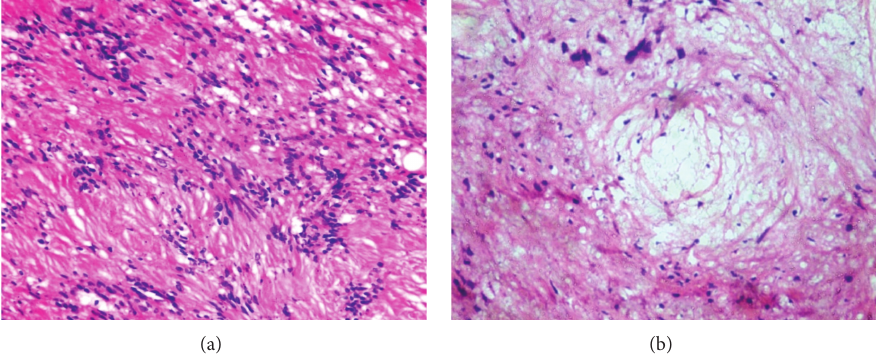
Figure 6: (a) Histopathological view of 10x shows Antoni A: cellular region, nuclei palisaded in arrangement around central acellular eosinophilic areas, and Verocay bodies. (b) Histopathological view shows Antoni B: relatively acellular in a loose, myxomatous